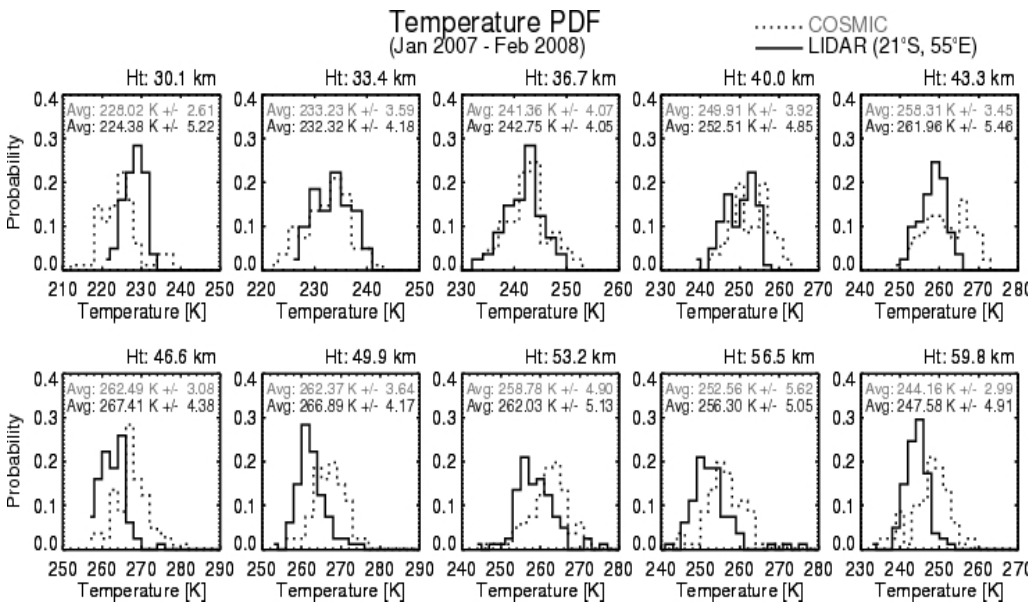
Fig. 8b. The probability distribution function (PDF) obtained between LIDAR and COSMIC temperature values at selected heights. Figure 8b: The probability distribution function (PDF) obtained between LIDAR and 8 COSMIC temperature values at selected heights. 9